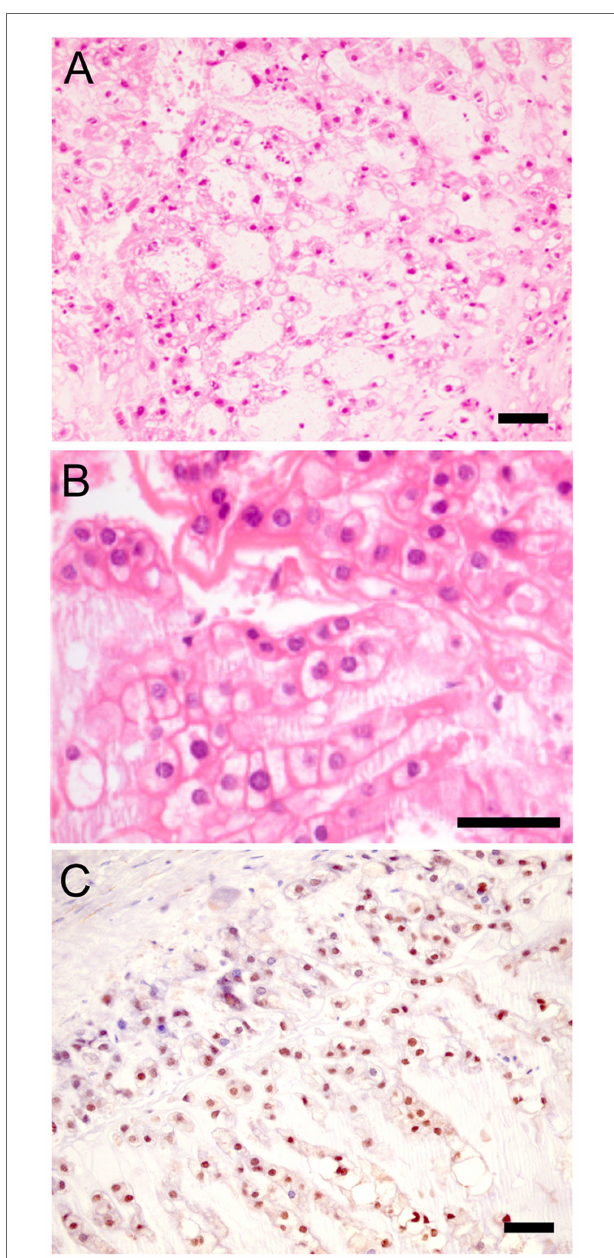
FIGURe 1 | Histological appearance of chordoma . (a,B) Sections of primary tumor stained with hematoxylin and eosin (H&E). (C) Parallel section stained for brachyury. Scale bar: 50 μ